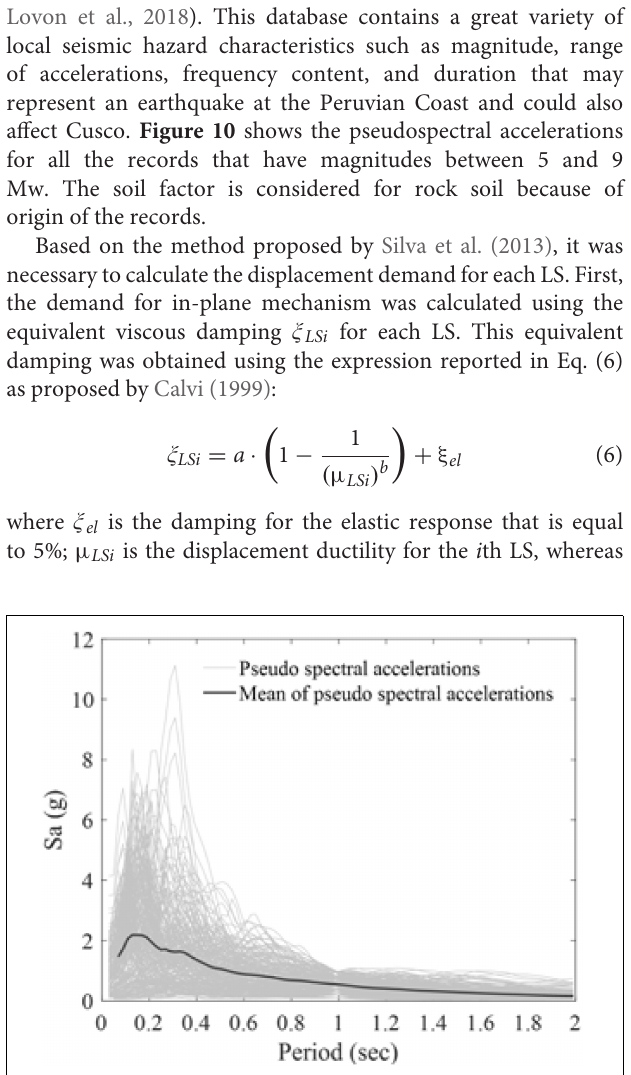
Lovon et al., 2018). This database contains a great variety of